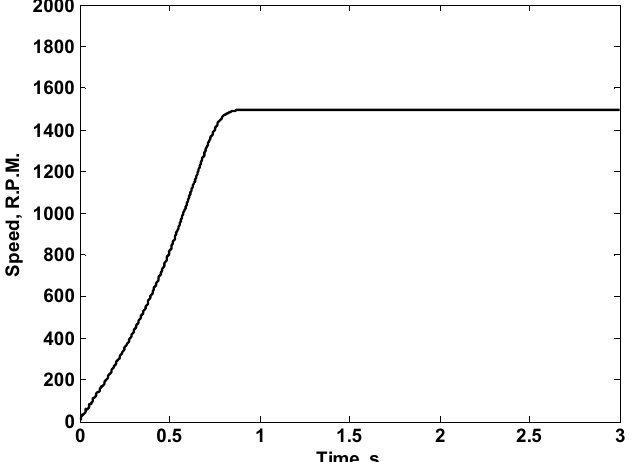
Figure 20. Three-Phase Motor Currents when Excited with 220 V, 50 Hz.